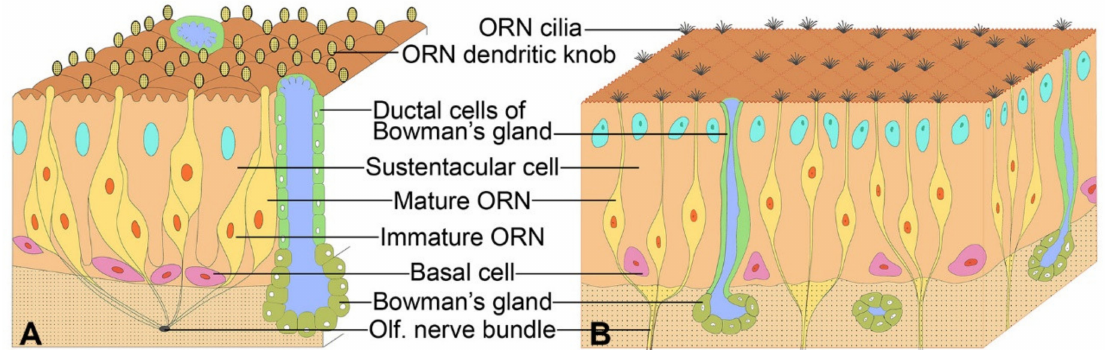
Figure 2. Schematic illustrations of the olfactory epithelium cytology as described in some of the recent publications [29,30]. Both illustrations clearly assumed olfactory receptor neuron (ORN) dendrite positions between olfactory sustentacular cells (OSCs). ( A ) Re-drawn and modified with permits from [29] and ( B ) re-drawn from [30] with